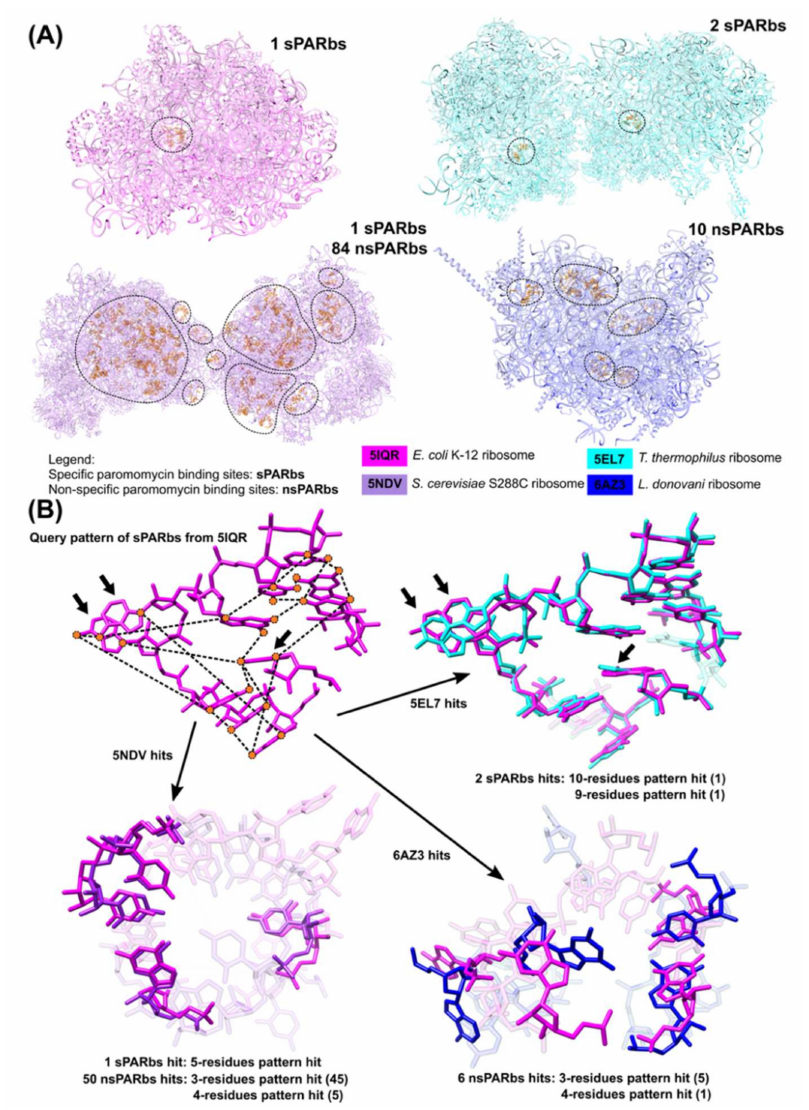
Figure 6. Identification of functional (paromomycin binding) sites in RNA structures from the PDB by NASSAM. ( A ) The regions on RNA structures (PDB ID: 5IQR, 5EL7, 5NDV, and 6AZ3) that contain the extracted binding sites are enclosed within black dashed lines and the binding sites are represented as orange sticks. ( B ) The specific paromomycin binding site from 5IQR that is identified by the presence of an AA-A motif (black arrows) is used as a query pattern in the NASSAM search. In the query pattern, the pseudo-atoms of bases are denoted as graph nodes (orange circles) and the distances between pseudo-atoms are denoted as graph edges (black dashed lines). The query pattern is used by the NASSAM algorithm to search for sites that exhibit similar base arrangements (hits) in other RNA